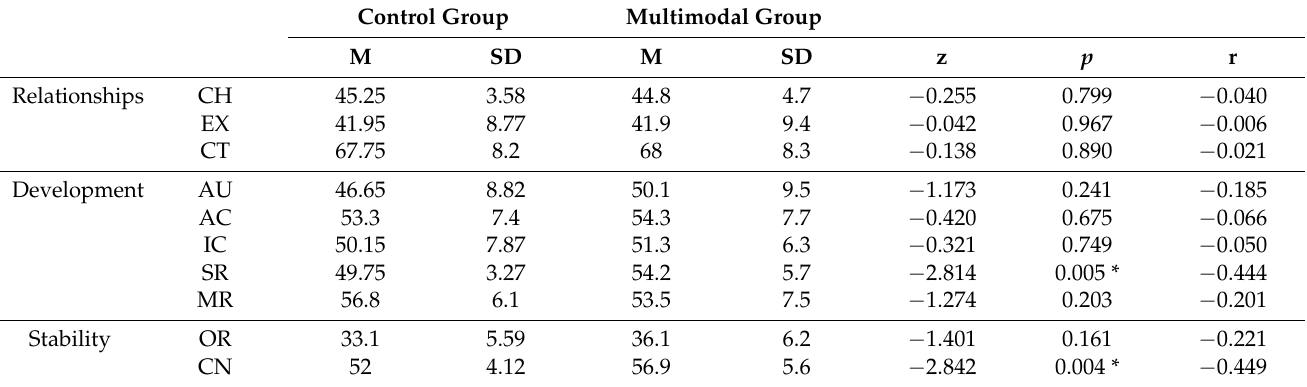
Table 12. Comparison between control and multimodal groups in the pre-test. Family climate. Control Group